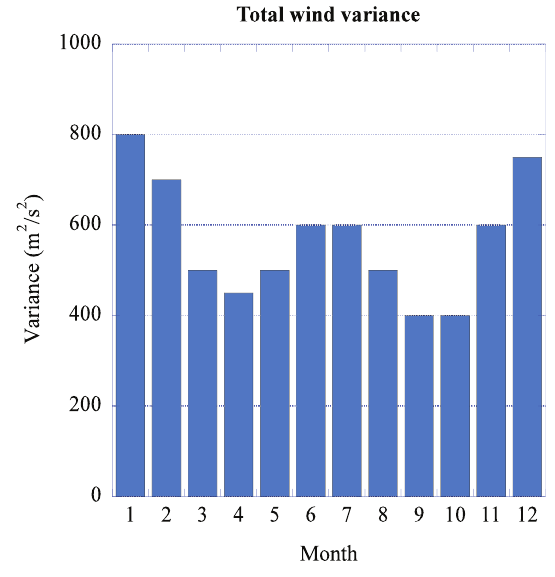
Fig. 3. Total wind variance at 87 km adopted from Fig. 4 of Gardner and Liu